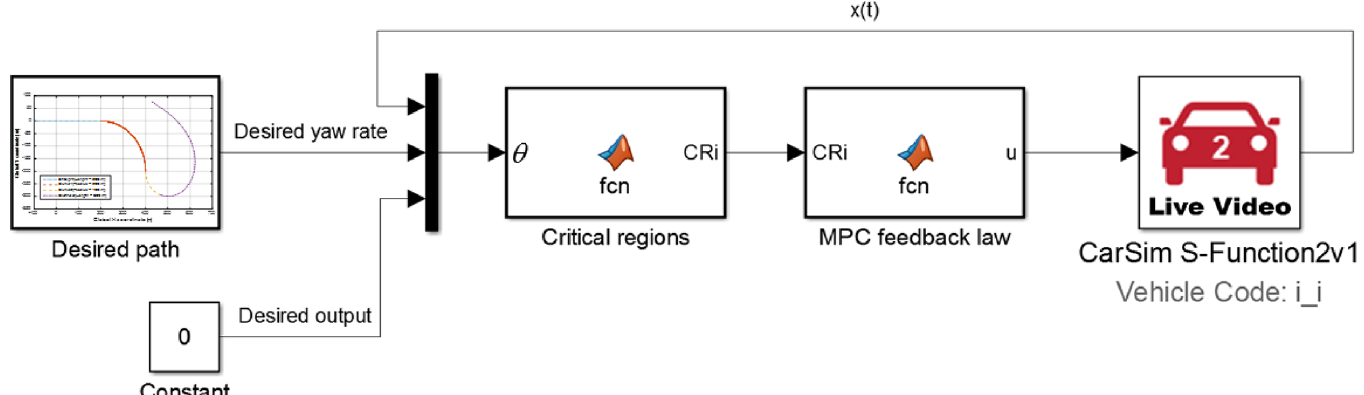
Fig 4. Explicit MPC controller structure. Structure of an explicit MPC controller for path-following control constructed using a vehicle model from CarSim. Based on the values of the parameter vector θ , the block “critical regions” selects a critical region CRi ; then, the block “MPC feedback law” calculates the control action by applying the first MPC feedback law to the selected critical region CRi